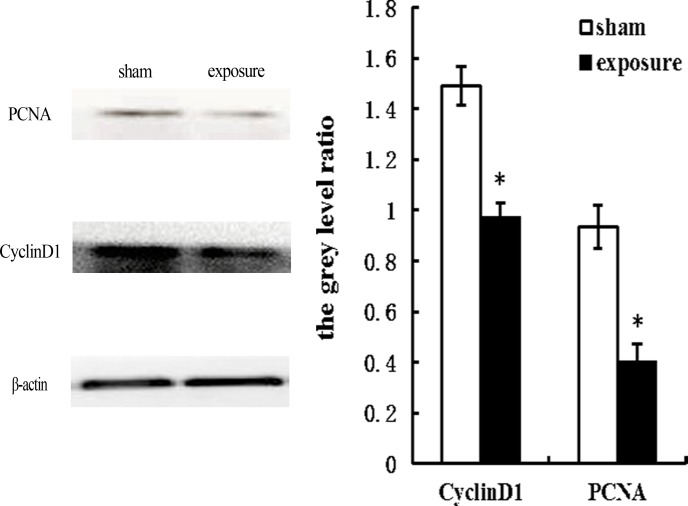
The protein level of PCNA and CyclinD1 in Balb/c 3T3 cells after 11 weeks PF-EMF exposure.β-actin was used as the internal control. The grey level ratio = the grey level of targeted protein/the grey level of β-actin. *vs. sham group, P<0.05.